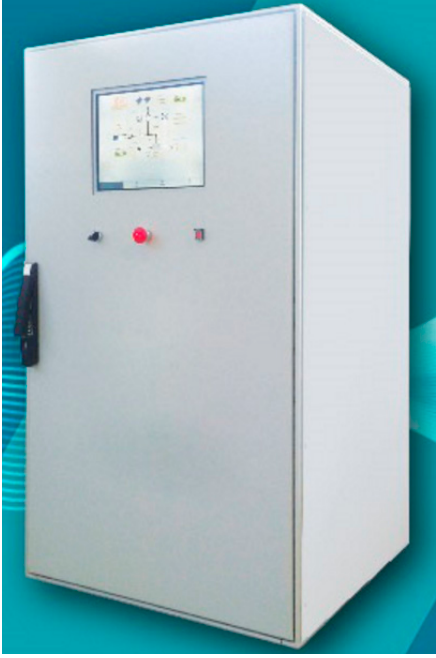
Figure 1. Appearance of HyREI equipment (developed by ALI6 srl ‐ Italy).